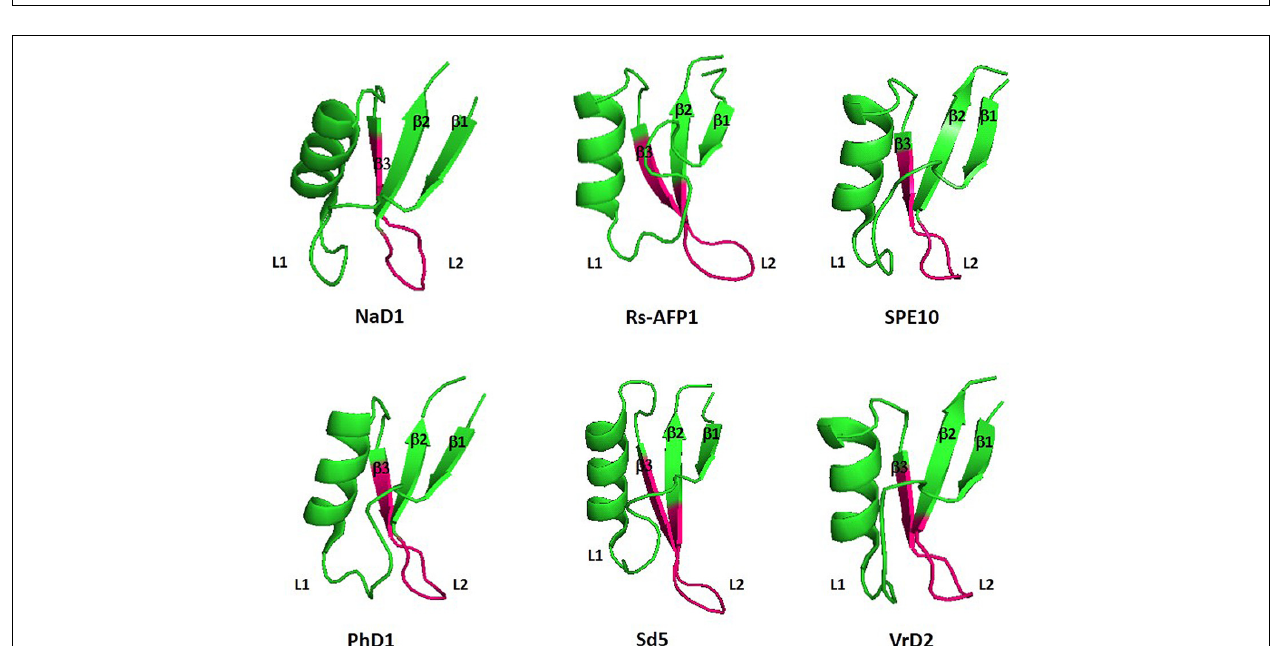
FIGURE 2 |Three-dimensional structure of six antifungal defensins from plants. Pink region highlight the γ -core motif of each peptide. β 1: β -sheet